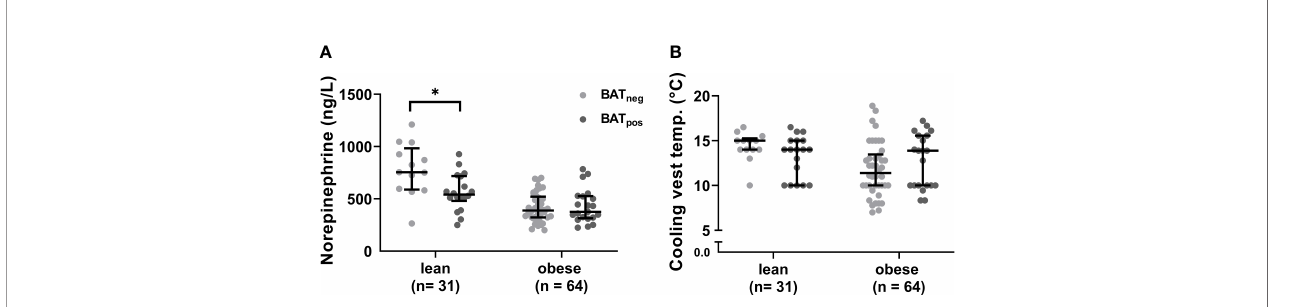
FIGURE 2 | Cold-induced norepinephrine concentrations and cooling vest temperatures. Norepinephrine plasma levels after cold exposure in BAT neg and BAT pos participants within each weight group (A) . Cooling vests temperatures between lean and obese individuals (B) . The graphs indicate median values and interquartile ranges. *p ≤